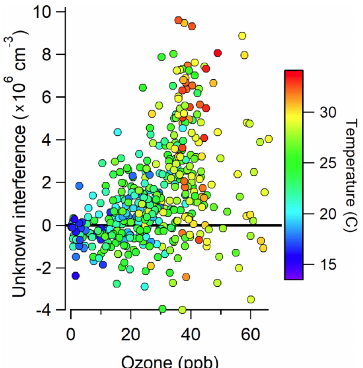
Figure 4. Measurements of the unknown interference as a function of ozone and temperature during the